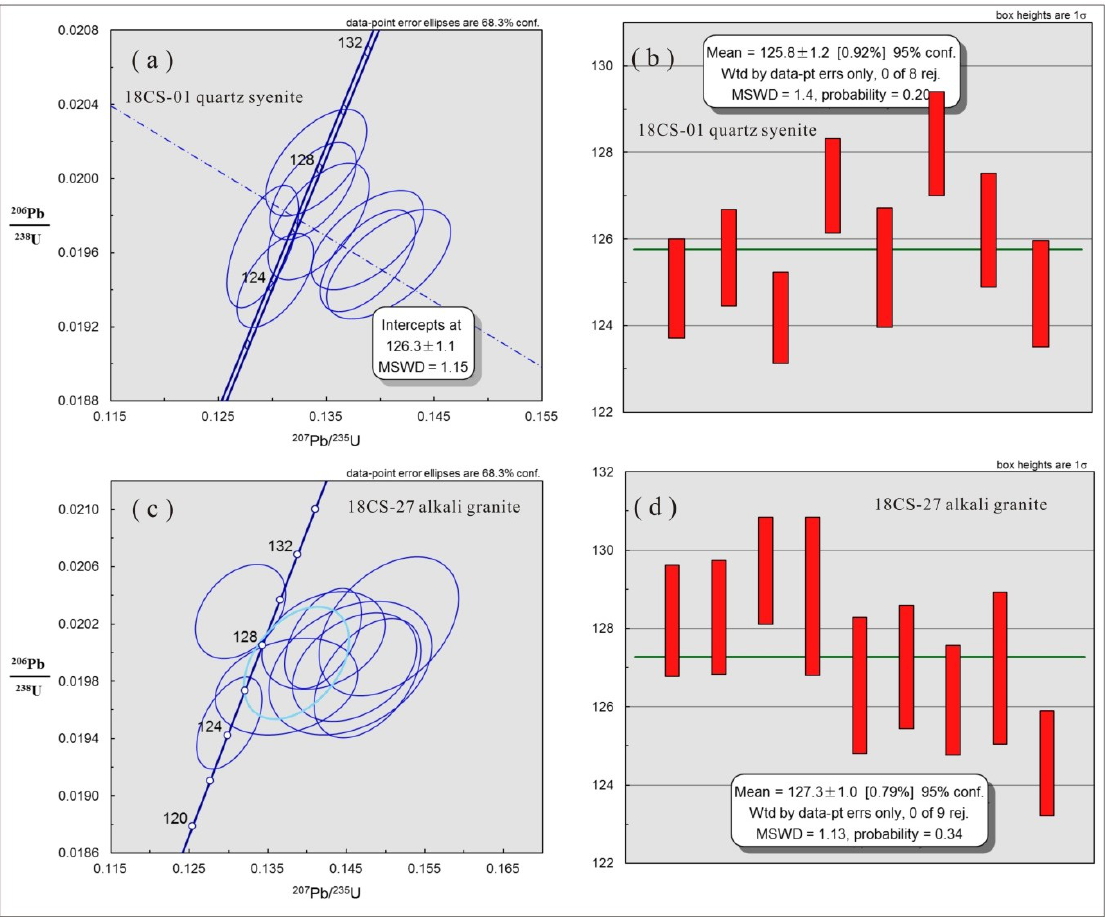
Figure 7. Zircon U–Pb age concordia plot of the Chishan alkaline complex. ( a ) is the concordia plot of quartz syenite (18CS-01); ( b ) is the average plot of quartz syenite (18CS-01); ( c ) is the concordia plot of alkali granite (18CS-27); ( d ) is the average plot of alkali granite (18CS-27).